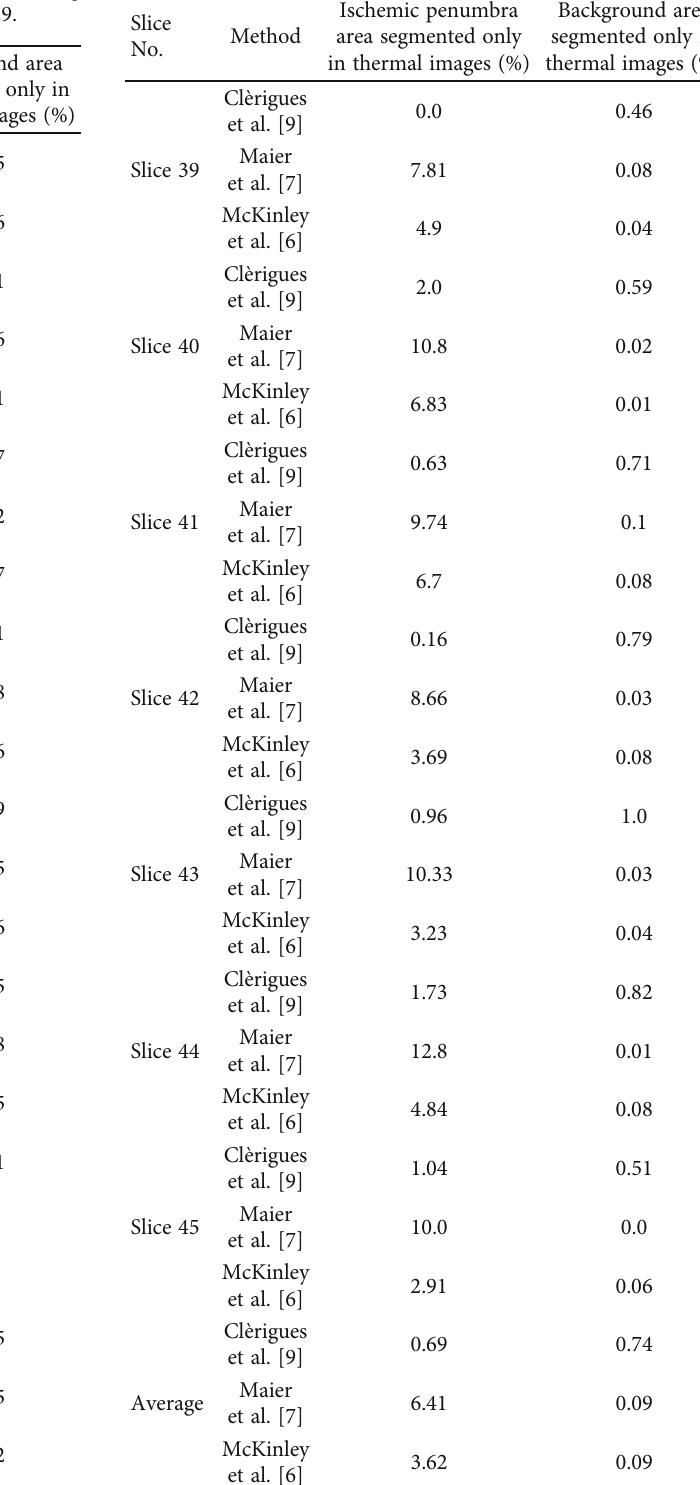
Table 4: The percentage of ischemic penumbra and background areas segmented in thermal images and not segmented using methods from the literature in slices taken from subject